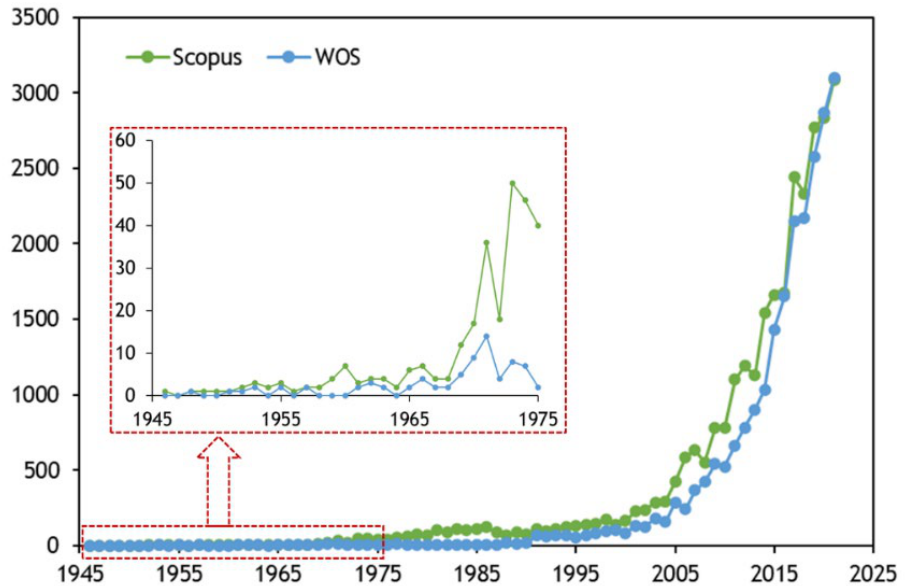
Figure 2. Evolution of the number of publications with the keyword “Thermal Comfort” in Scopus and WOS.